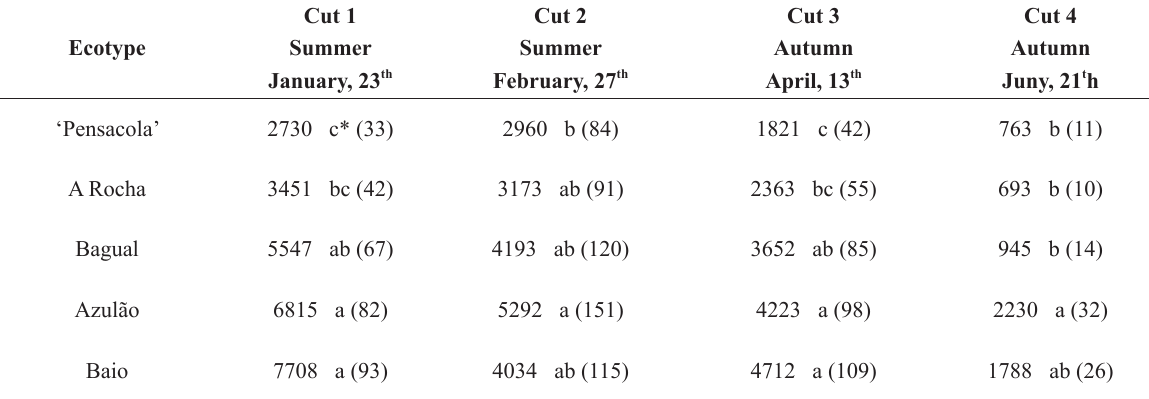
Total dry matter production in kg/ha in each cut in the first year of evaluation of ecotypes of Paspalum spp. and cv. ‘Pensacola’, EEA-UFRGS, Eldorado do